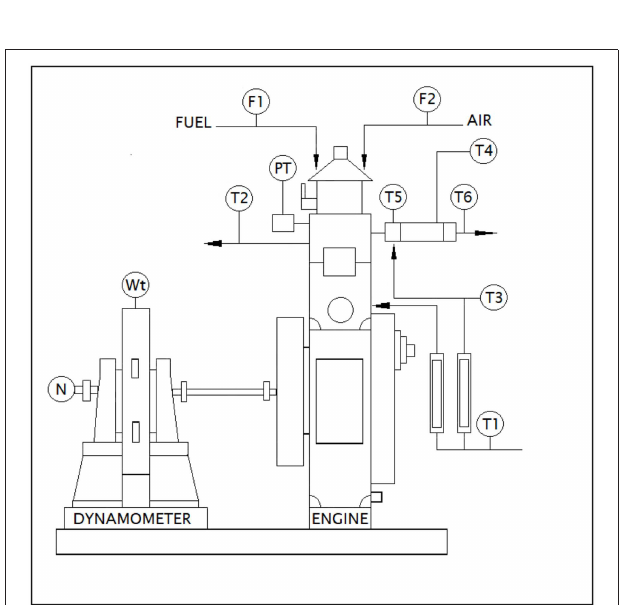
FIGURE 2 | Schematic diagram of test engine setup. Source: Apex innovations (Research equipment supplier in India).